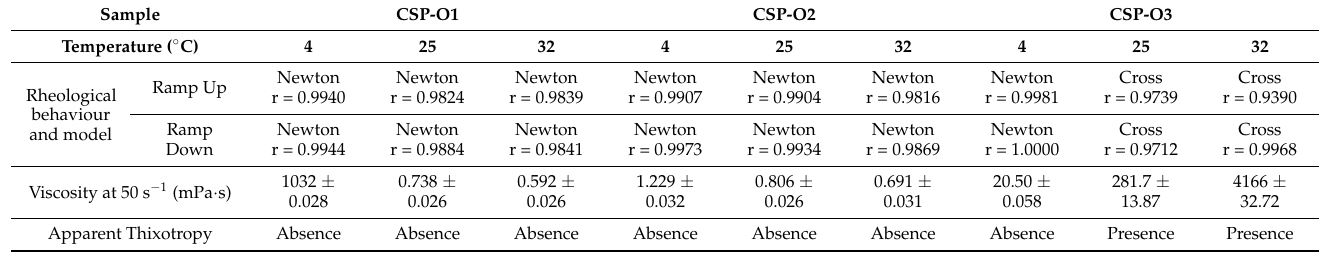
Table 2. Results of the rheological rotational testing of the formulations. Each value of viscosity represents the mean ± SD ( n = 3).